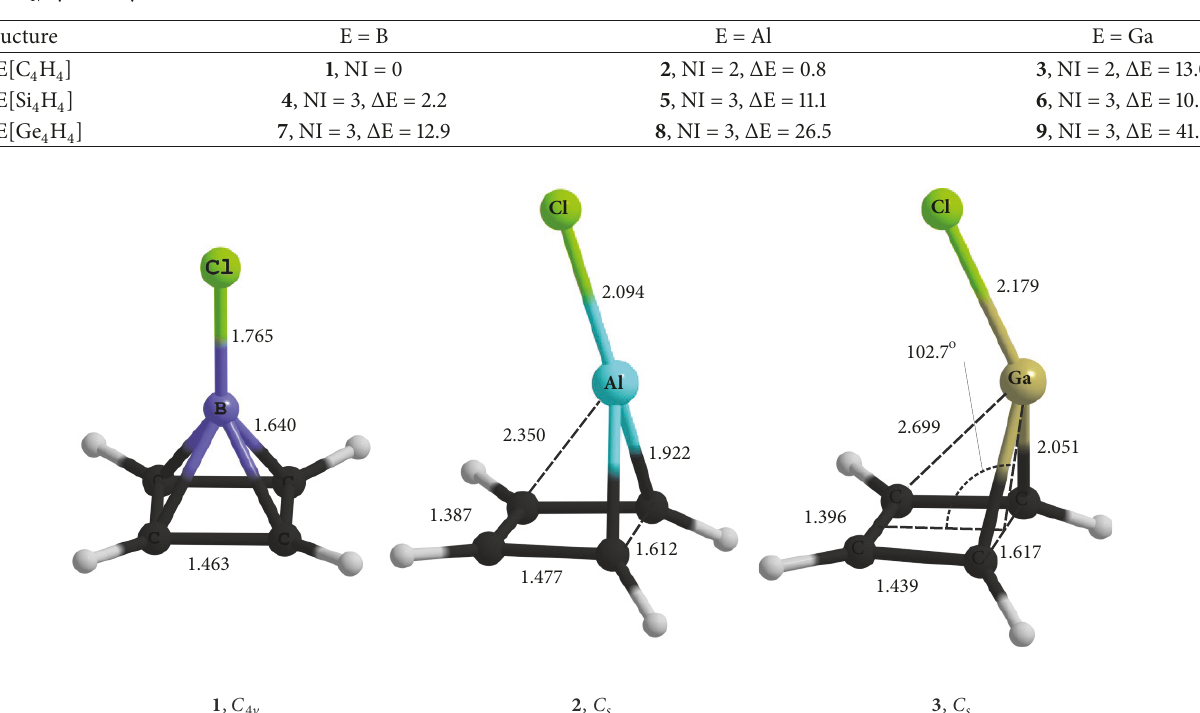
Table 1: Numbers of imaginary frequencies (NI) and relative energies towards closest minima ( (cid:2) E, kcal mol −1 ) for model pyramidal systems 1–9 ( 𝐶 4 V symmetry).